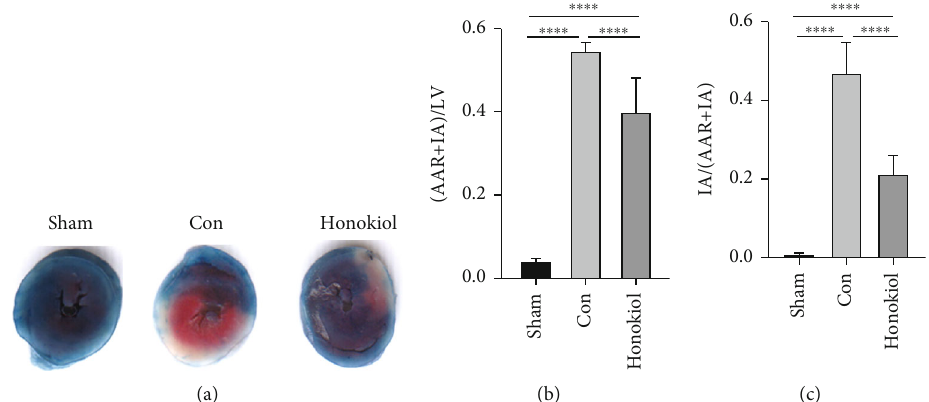
Figure 2: Measurement of the myocardial infarct area. (a) TTC-Evans blue staining. (b) Assessment of myocardial infarct area. Both the proportion of aggregate ischemic areas and necrotic areas were elevated in the Con cohort as opposed to the Sham cohort and were considerably decreased by Honokiol treatment. N = 10 for each cohort. Data are articulated as mean ± SEM . ∗∗∗ ∗ p < 0 : 0001